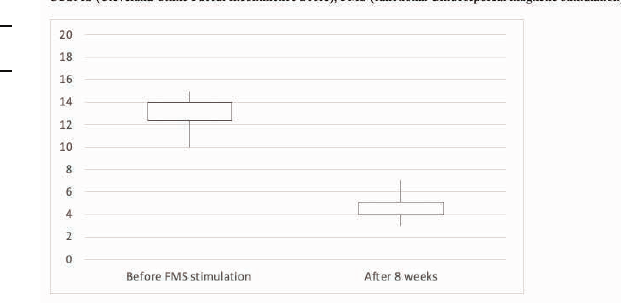
Table 1: Patients demographics features. Values are expressed as number of cases or mean (*). FI (Fecal Incontinence)